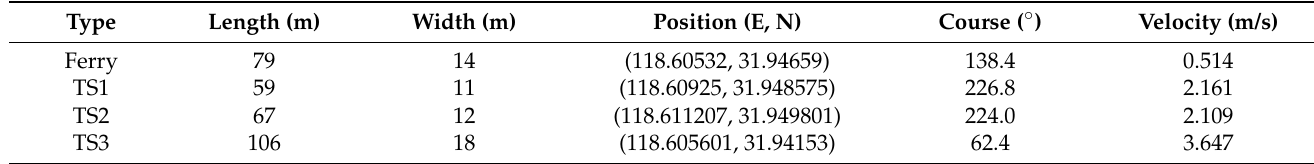
Table 2. Dynamic and static parameters.